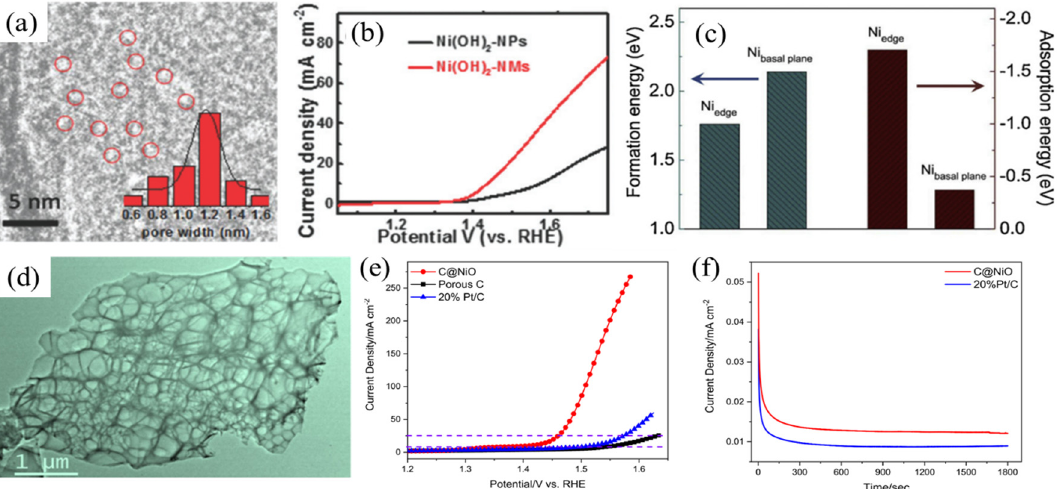
Figure 4. ( a ) TEM image of Ni(OH) 2 -NMs; ( b ) comparison of LSV curves of Ni(OH) 2 -NMs and